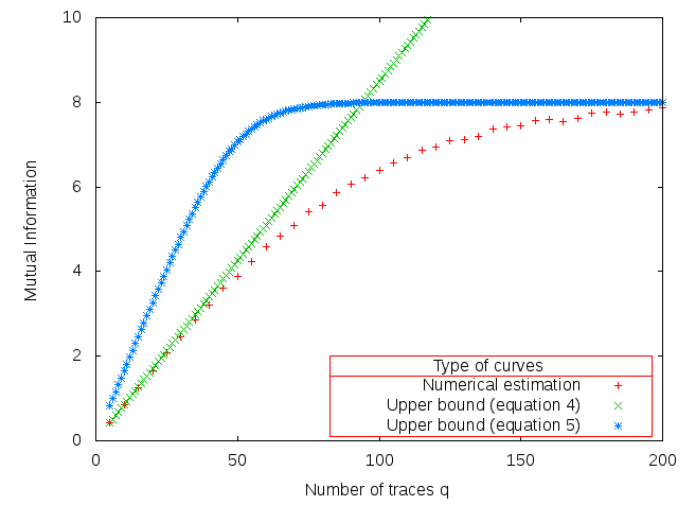
Figure 3: Comparison of the two upper bounds (4) and